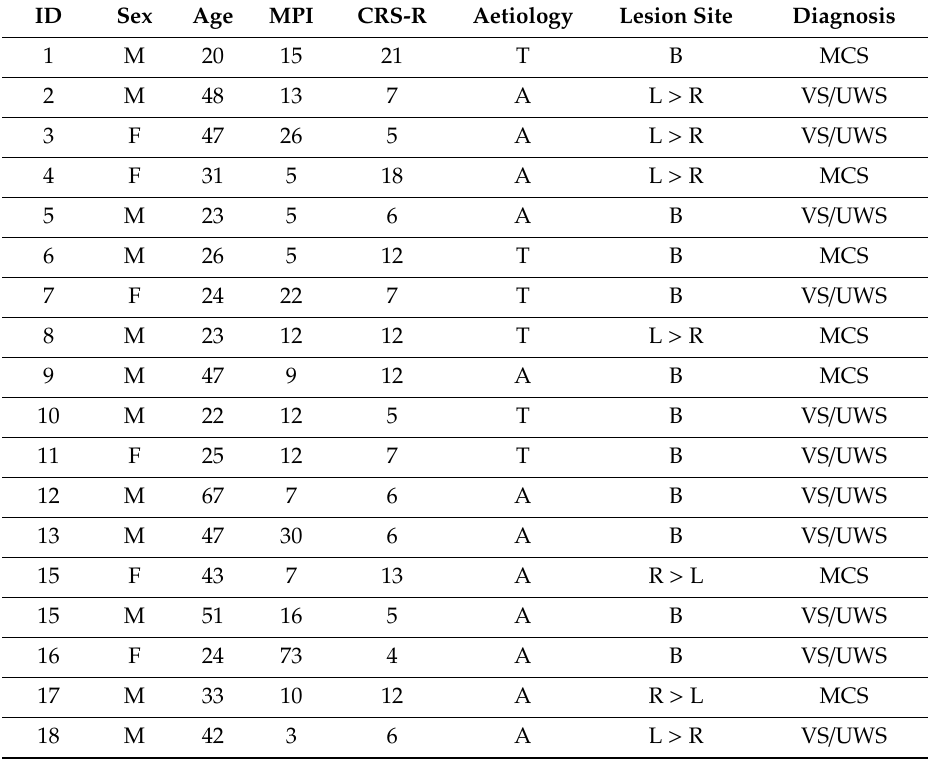
Table 1. Demographic and clinical data of